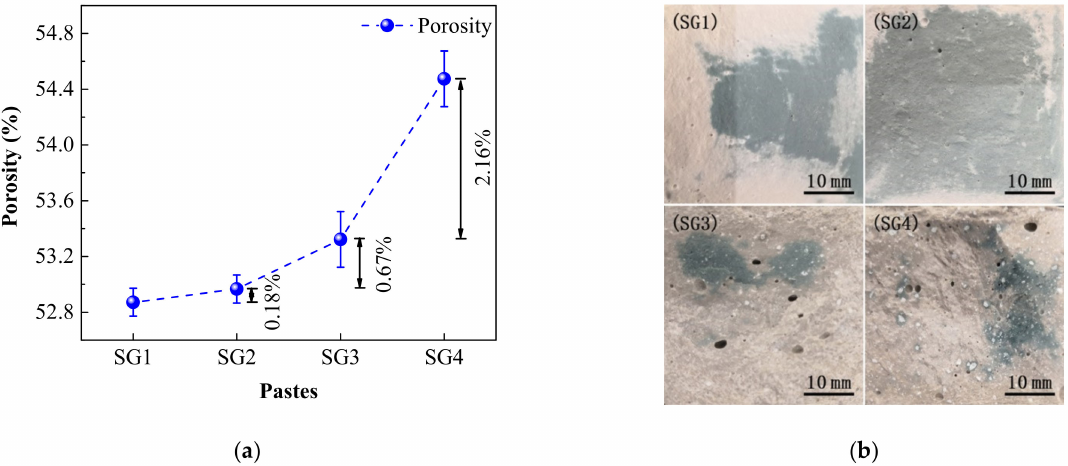
Figure 5. Porosity ( a ) and fracture surfaces ( b ) of the pastes at 28